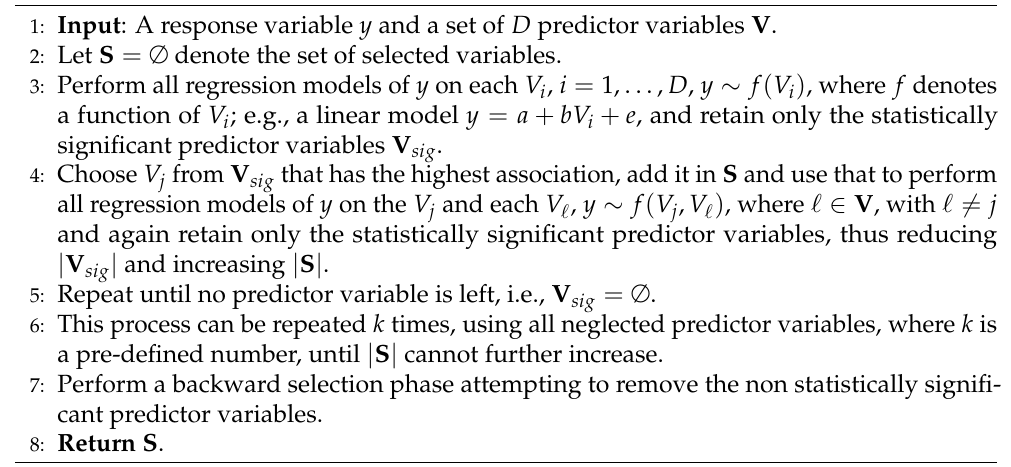
Algorithm 1 The FBED variable selection